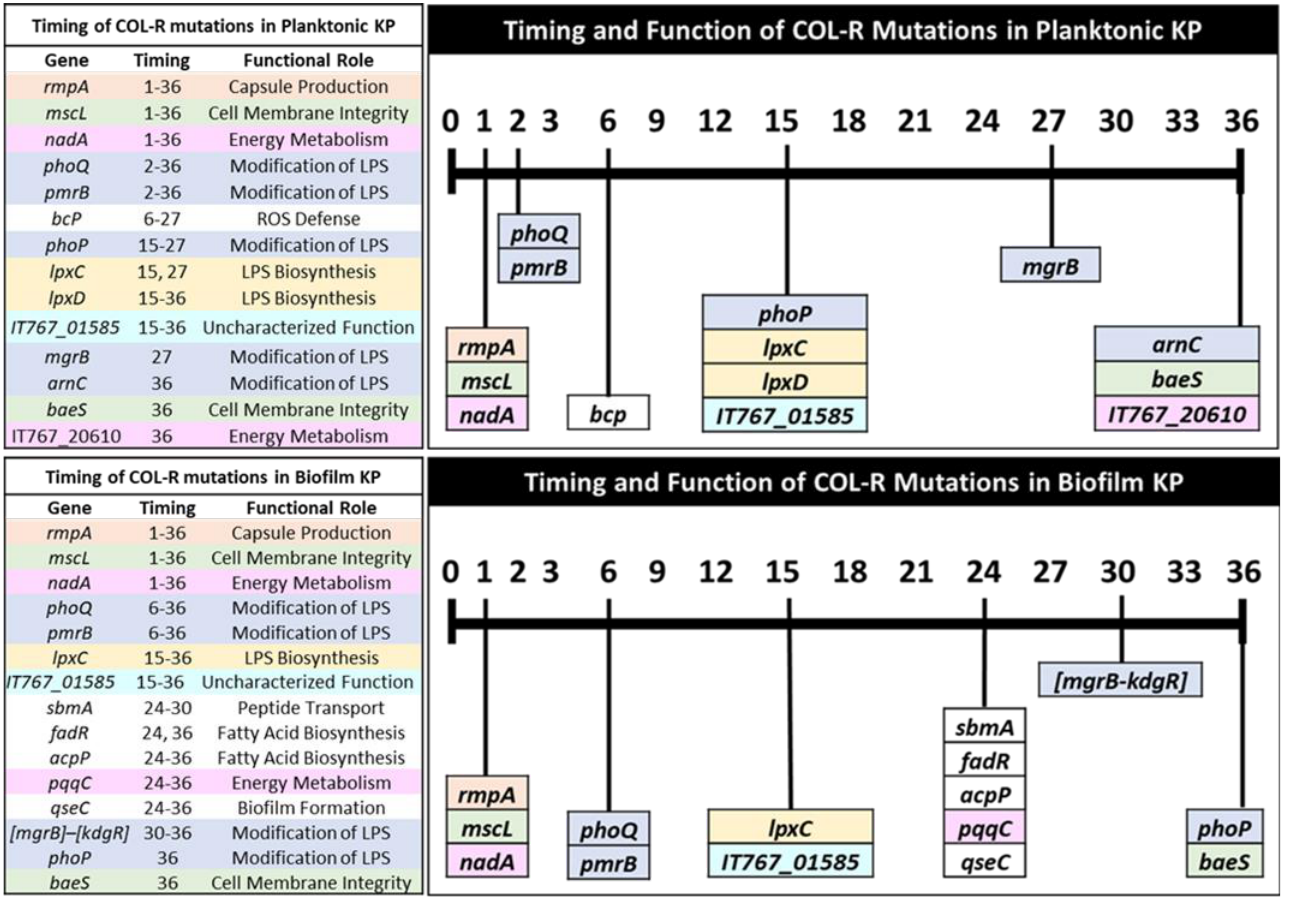
Figure 4. Timing of colistin-resistant mutations by functional role for independent KP lifestyles. Mutations are listed in relation to the first appeared time during evolution and color-coded by functional role to compare COL-R resistance patterns in planktonic and biofilm lifestyles. The timing in which shared mutations are generated and their corresponding functions can be compared between planktonic and biofilm-evolved KP. The colors in the bars are used to identify the individual or combinations of mutations generated at a similar timeframe throughout colistin selection. There is no connection between the color scheme used here and in other figures in this manuscript.